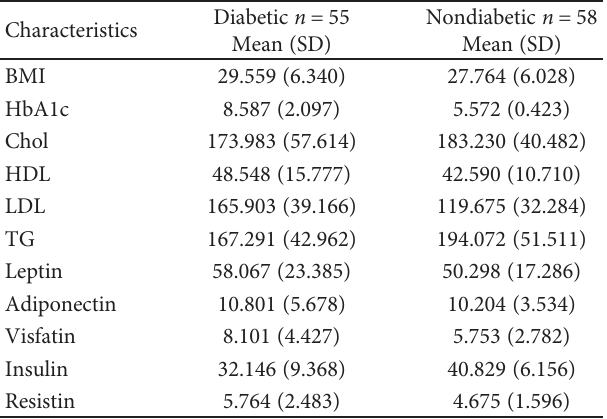
Table 1: Background characteristics of the subjects in the two groups diabetic and nondiabetic. Characteristics